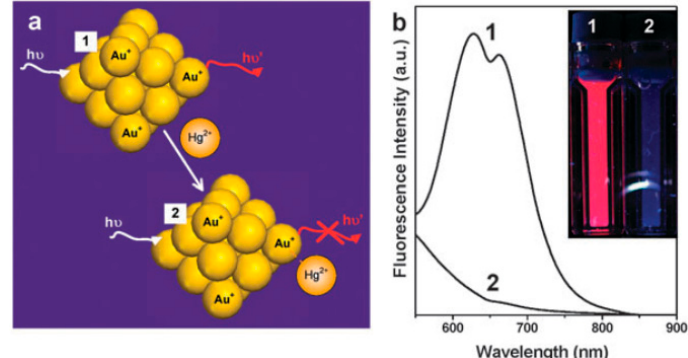
Figure 2. ( a ) Schematic of Hg 2 + sensing based on the fluorescence quenching of AuNCs resulting from high-affinity metallophilic Hg 2+ -Au + bonds. ( b ) Photoemission spectra and (inset) photographs under high-a ffi nity metallophilic Hg 2 + -Au + bonds. ( b ) Photoemission spectra and (inset) photographs under UV light of AuNCs before and after adding trace Hg 2+ . Adapted with permission from Reference [54] UV light of AuNCs before and after adding trace Hg 2 + . Adapted with permission from Reference [54] Copyright (2010) Royal Society of Chemistry. Copyright (2010) Royal Society of